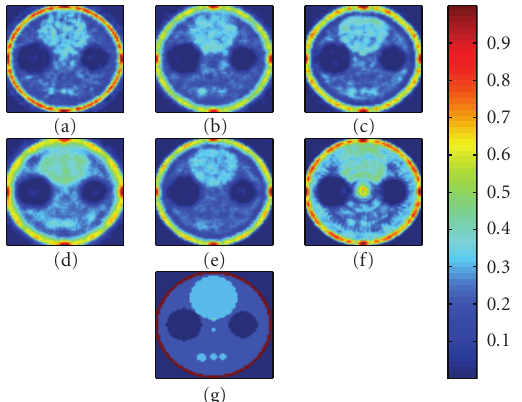
Figure 7: Comparison of reconstructed images from three-dimen- sional simulations.